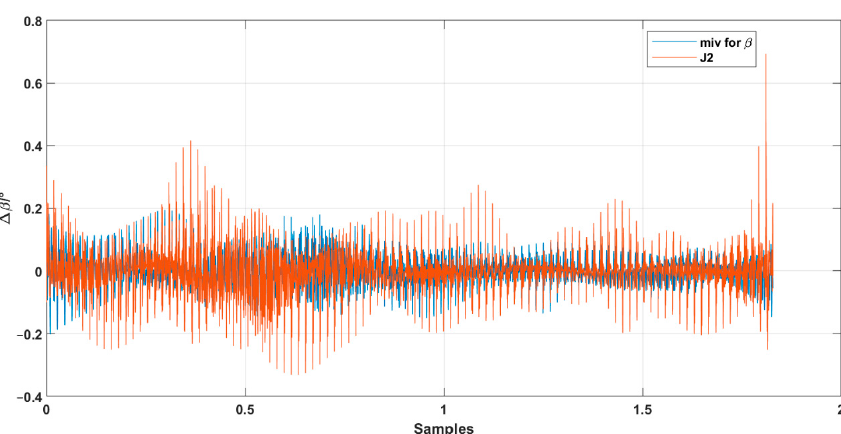
Figure 2. Comparison of the α prediction.